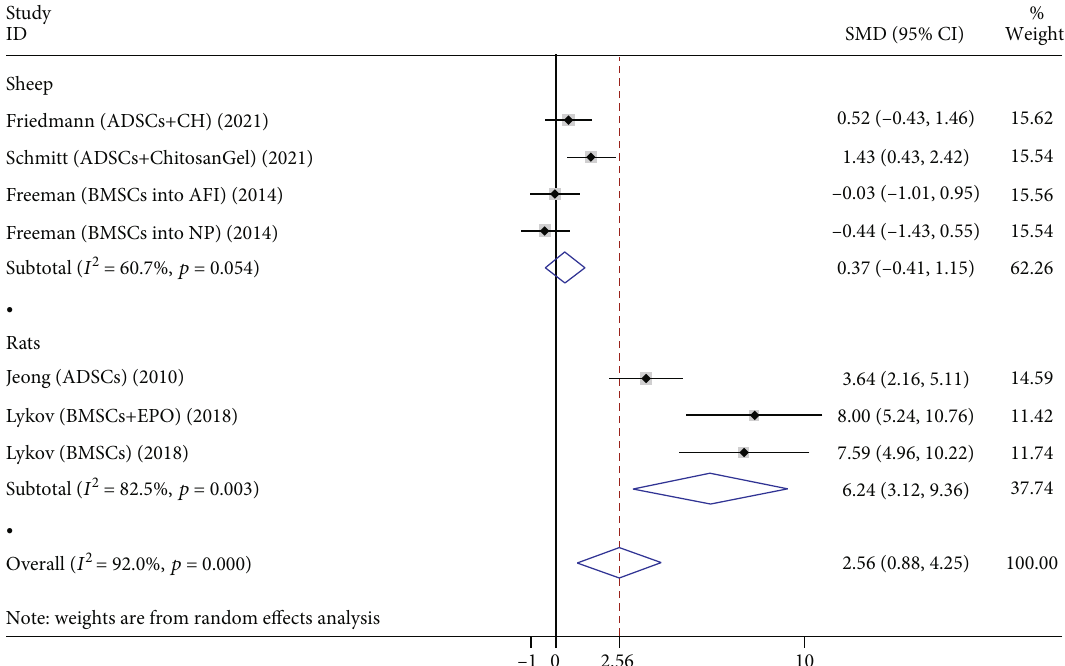
Lykov (BMSCs) (2018) Subtotal ( I 2 = 82.5%, p = 0.003)